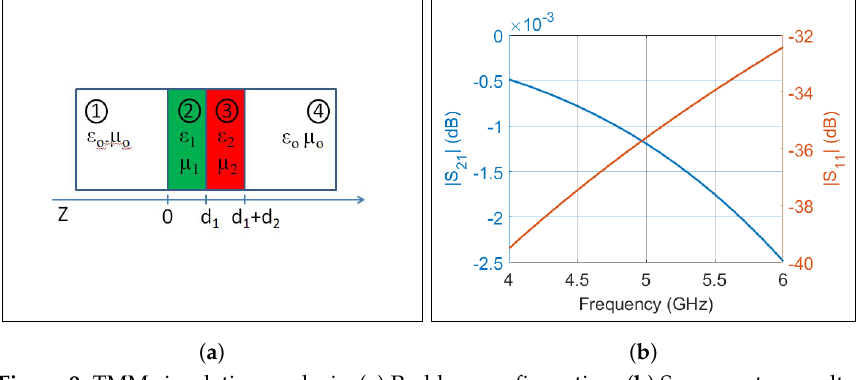
Figure 9. TMM simulation analysis. ( a ) Problem configuration. ( b ) S-parameter